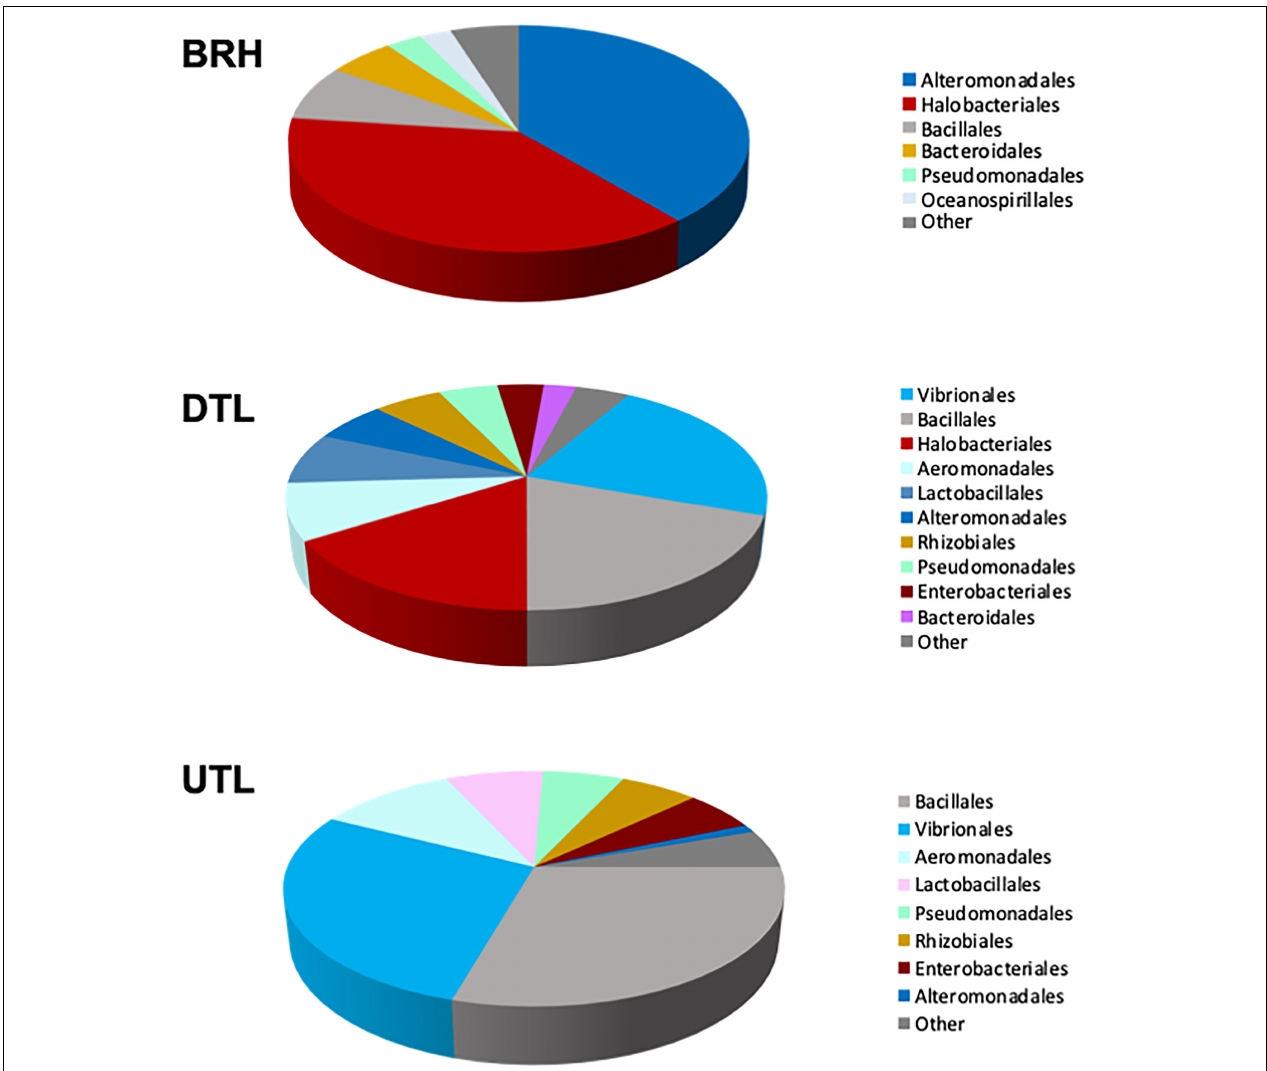
FIGURE 5 | Composition of the microbial communities, as percentage of sequences per taxonomic group, in rawhide (BRH), red damaged tanned leather (DTL), and undamaged tanned leather